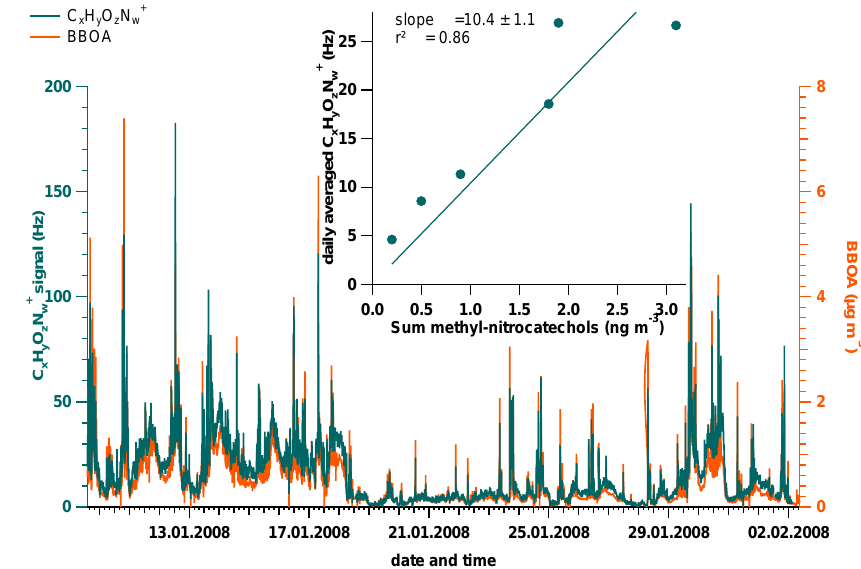
Fig. 5. Comparison of the C x H y O z N + w fragments with BBOA factor and daily PM 1